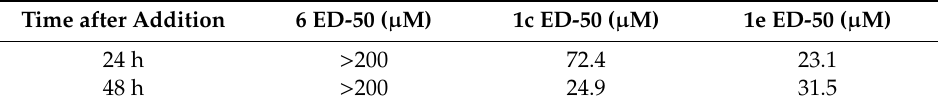
Table 6. Calculated ED-50 concentration for 1c and 1e at 24 and 48 h after